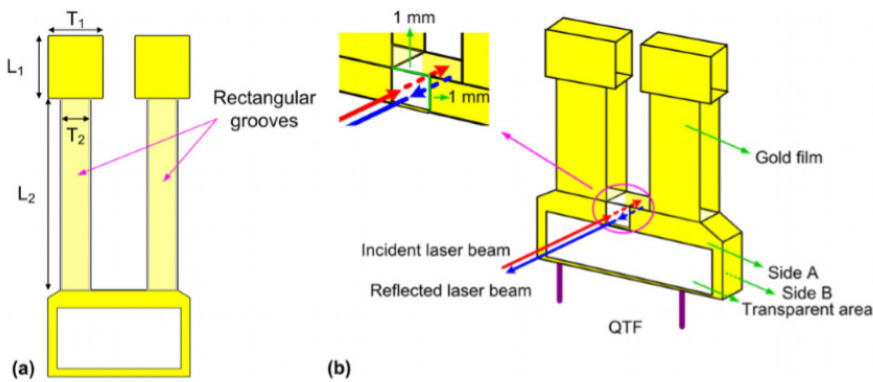
Figure 9. ( a ) Front view of a custom QTF. ( b ) Detailed view of the area selected for laser beam focusing. Reprinted/adapted with permission from Ref. [68]. Copyright 2020, copyright AIP Publishing. Table 1. The characteristic parameters of the used six QTFs. f : measured resonance frequency of the fundamental mode; Q -factor: related quality factor; τ : accumulation time; ε : maximum strain field. Reproduced with permission from Ref. [127]. Copyright 2020, copyright The Optical Society.